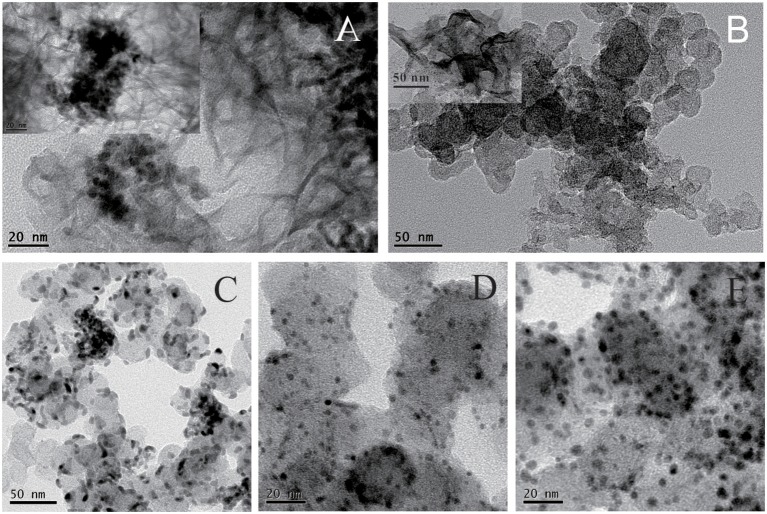
Representative TEM images of the prepared (A) Pd/Co-nanofilms materials, (B) the Co-nanofilms/C; TEM images of the prepared catalysts of (C) Pd/C, (D) Pd2Co/C, and (E) Pd2/Co-nanofilms/C.